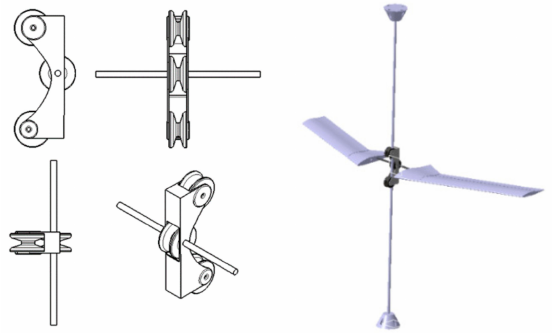
Figure 14. Suspension system for the BFF UAV wind tunnel